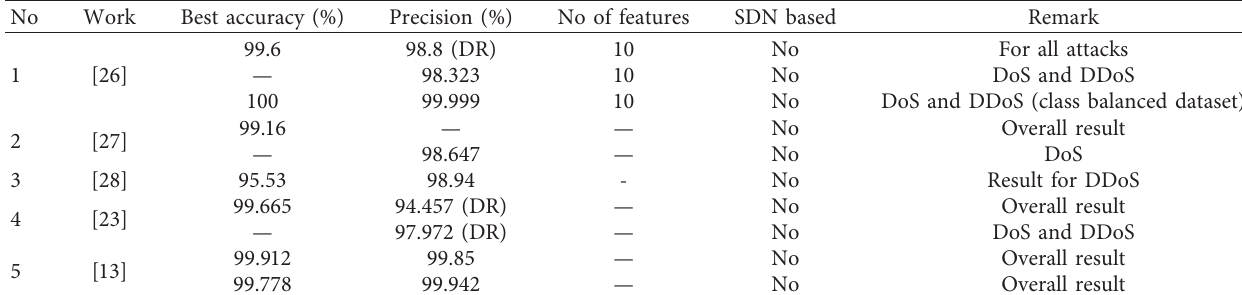
Table 8: Comparison with works involving the generic CICIDS2017